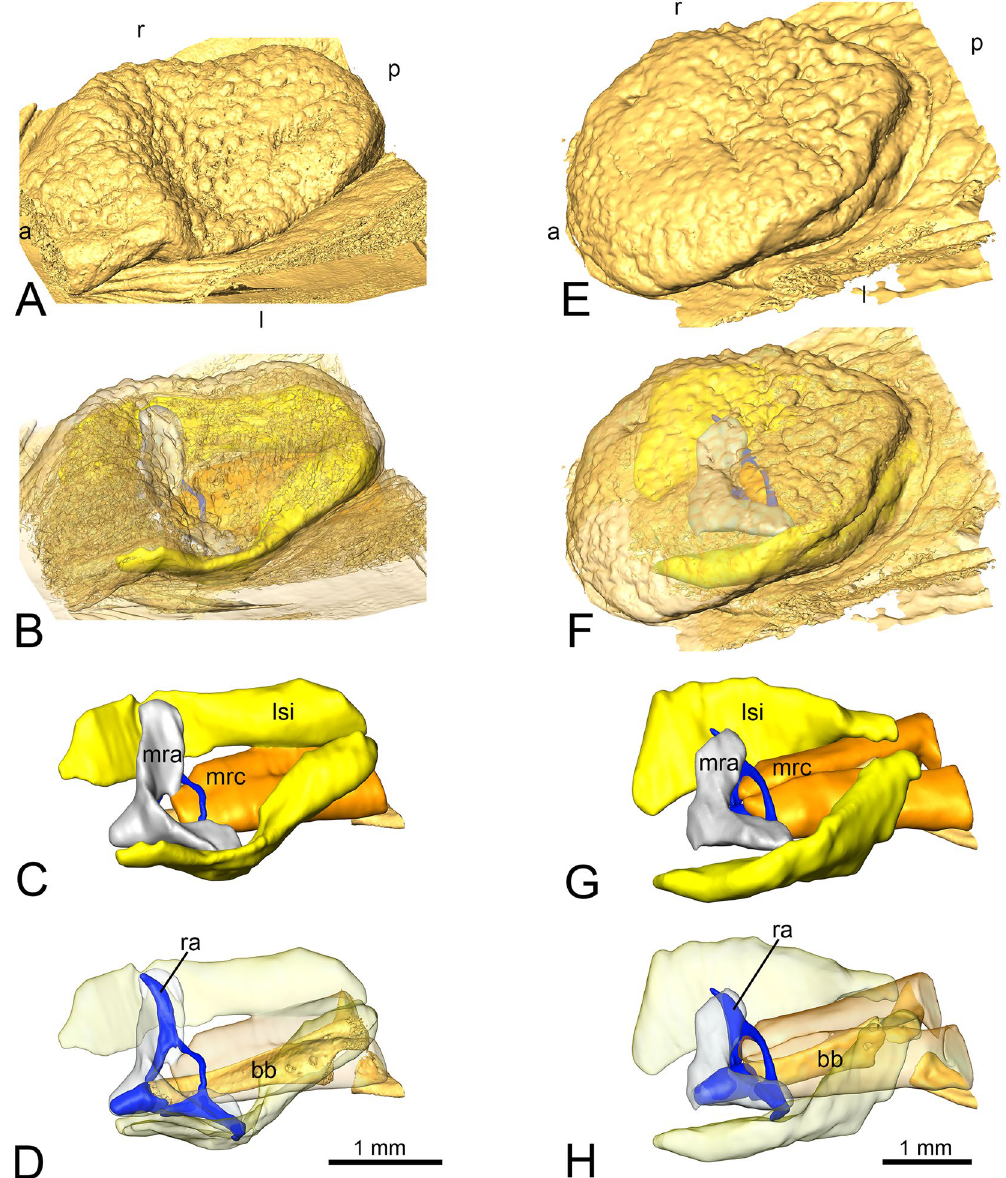
r, right. (ii) Anatomical structures: bb, basibranchial; lsi, lingual sinus; mra, radialis muscle; mrc, rectus cervicis muscle; ra, radial